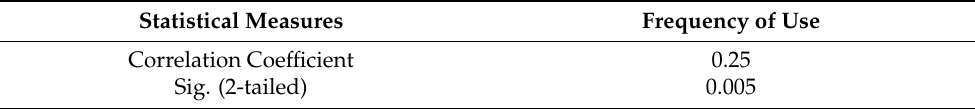
Table 2. The values of Spearman’s rank correlation coefficient. The relationship between age and the frequency of using overpass.